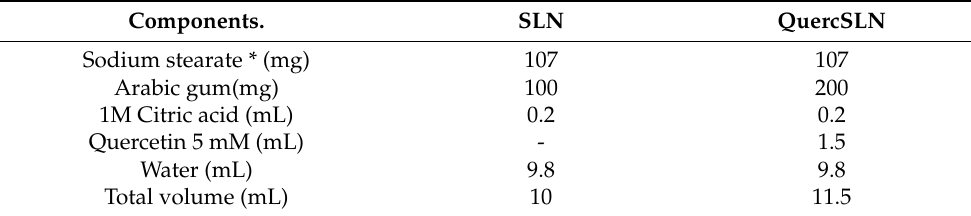
Table 1. Amounts of components used for Solid Lipid Nanoparticles synthesis. Components.